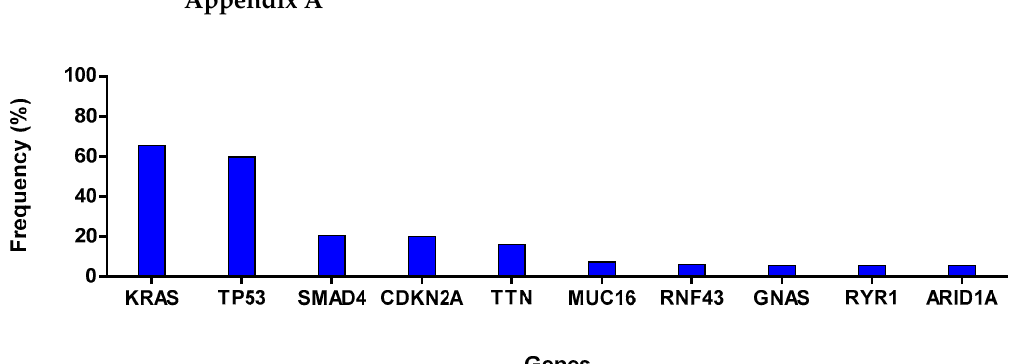
Figure A1. The top most frequently mutated genes in PDAC patients [TCGA, Pancreatic Atlas; n = 175] dataset.